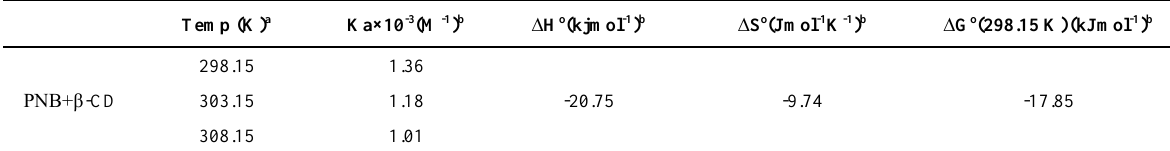
Table 4. Association constant (Ka) and thermodynamic parameters ∆H ∘ , ∆S ∘ and ∆G ∘ of different PNB -Cyclodextrin inclusion complexes.